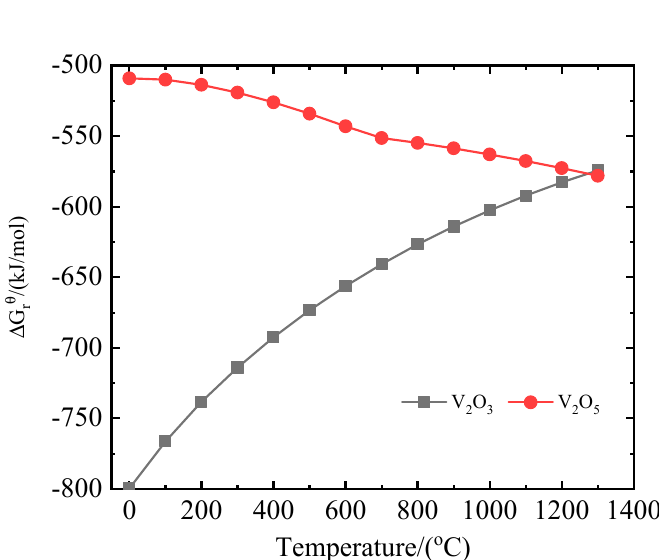
Figure 3. Variation of standard Gibbs free energy of reactions 21–22 with temperature. Under an oxygen atmosphere, the equations for the NaCl roasting reaction of V 2 O 3 and V 2 O 5 are as shown in Equations (23) and (24). Figure 4 shows the variation of standard Gibbs free energy of reactions 23–24 with temperature. Under the same conditions, V 2 O 3 is more easily chlorinated. Thermodynamically, increasing temperature is not conducive